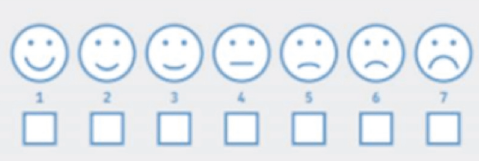
Figure 9: Satisfaction questionnaires in the second intervention for children in sixth grade (primary school).